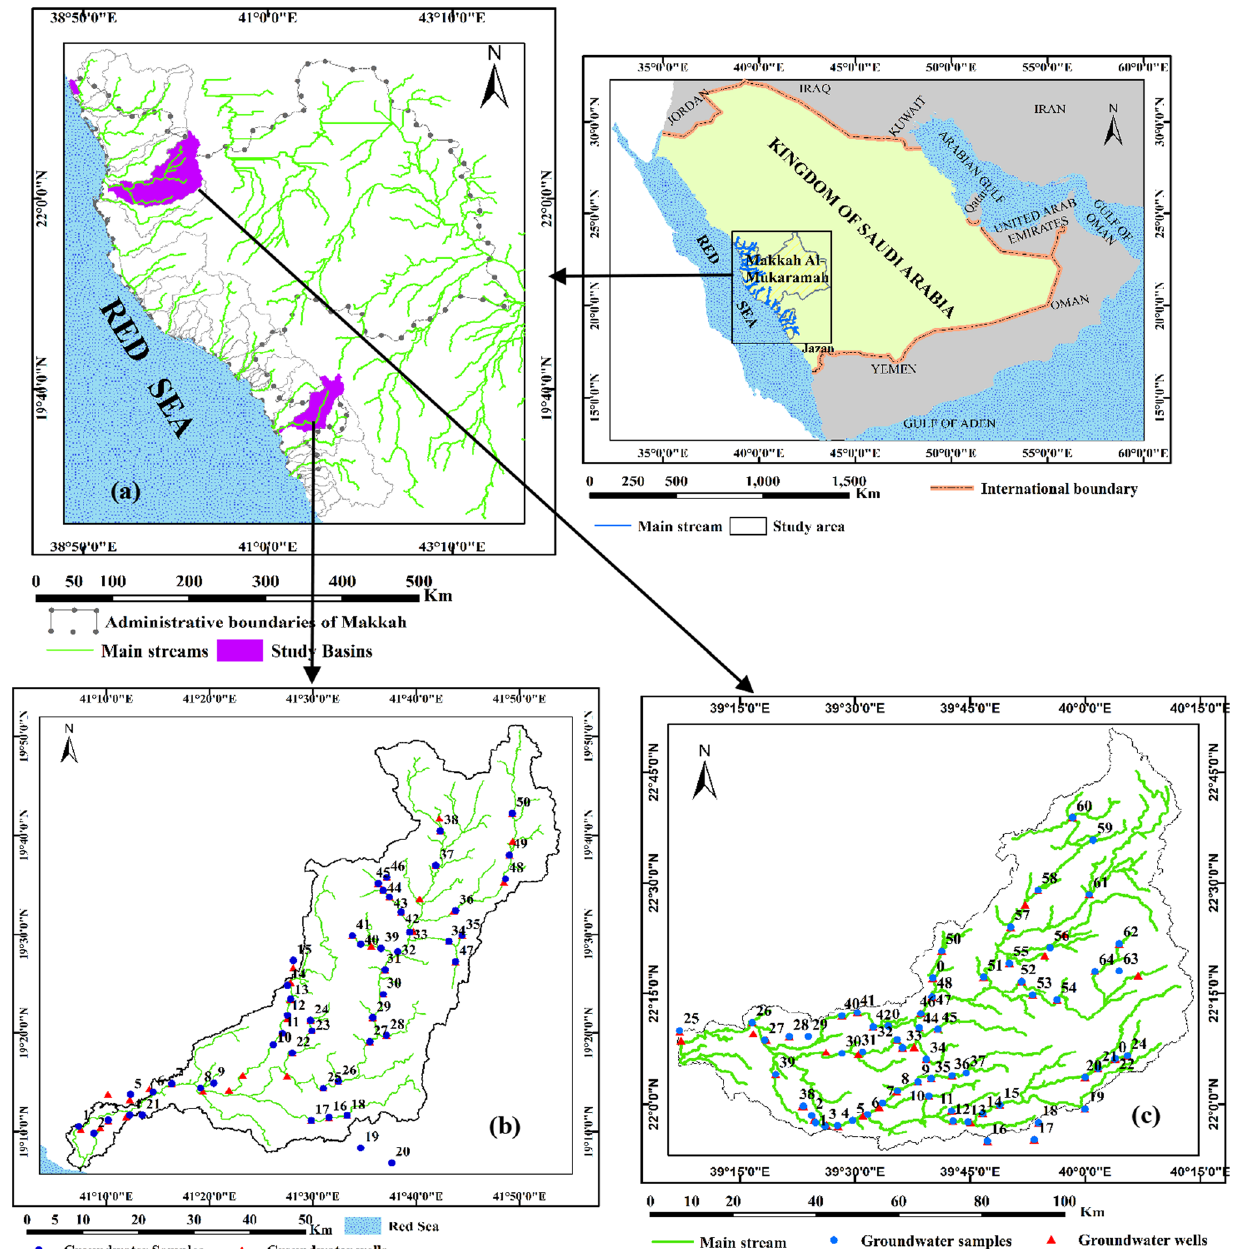
Fig. 1 Location maps of the investigated areas and measuring points: a Map of Makkah Al-Mukarramah Province, Saudi Arabia, and location of groundwater wells and water samples in Wadi Qanunah b and Wadi Marawani